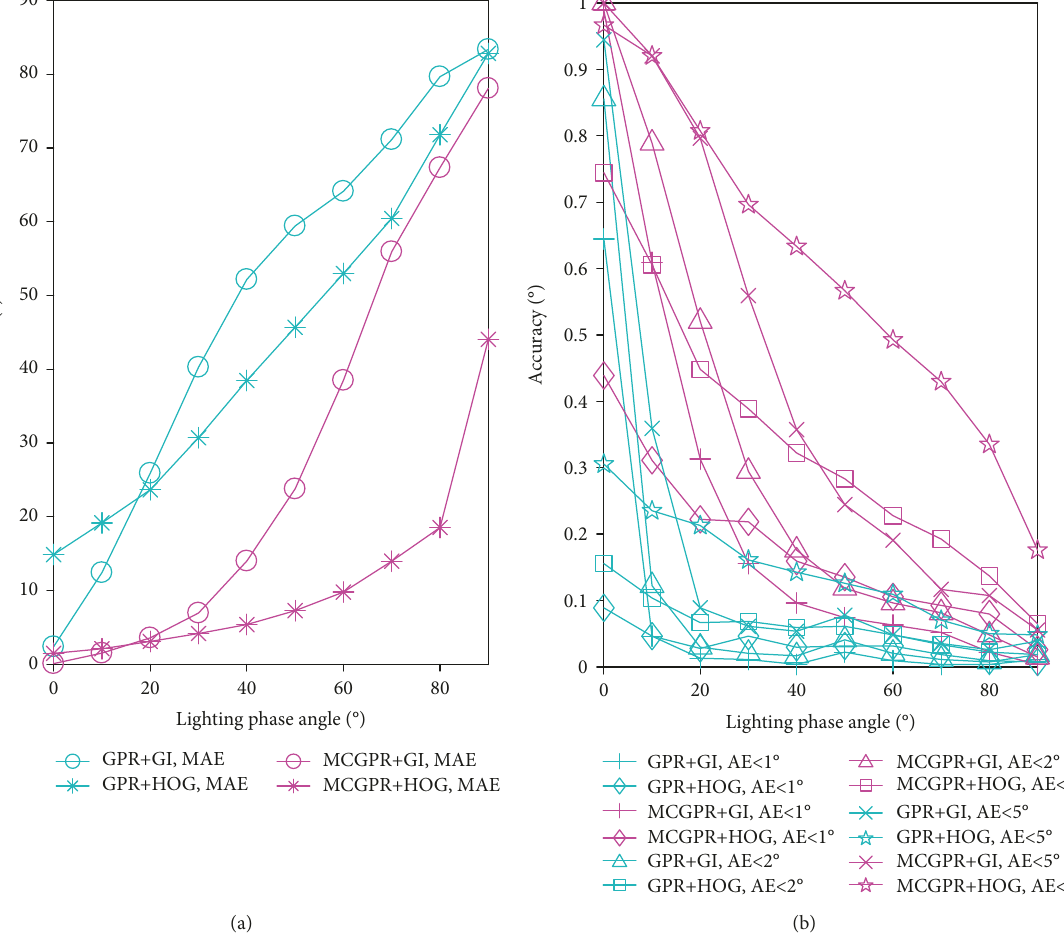
Figure 9: Lighting robustness results of pose estimation.